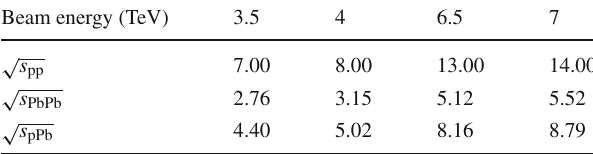
Table 2 The CM energy per nucleon for pp, pPb and PbPb collisions vs. the proton beam energy in TeV units Beam energy